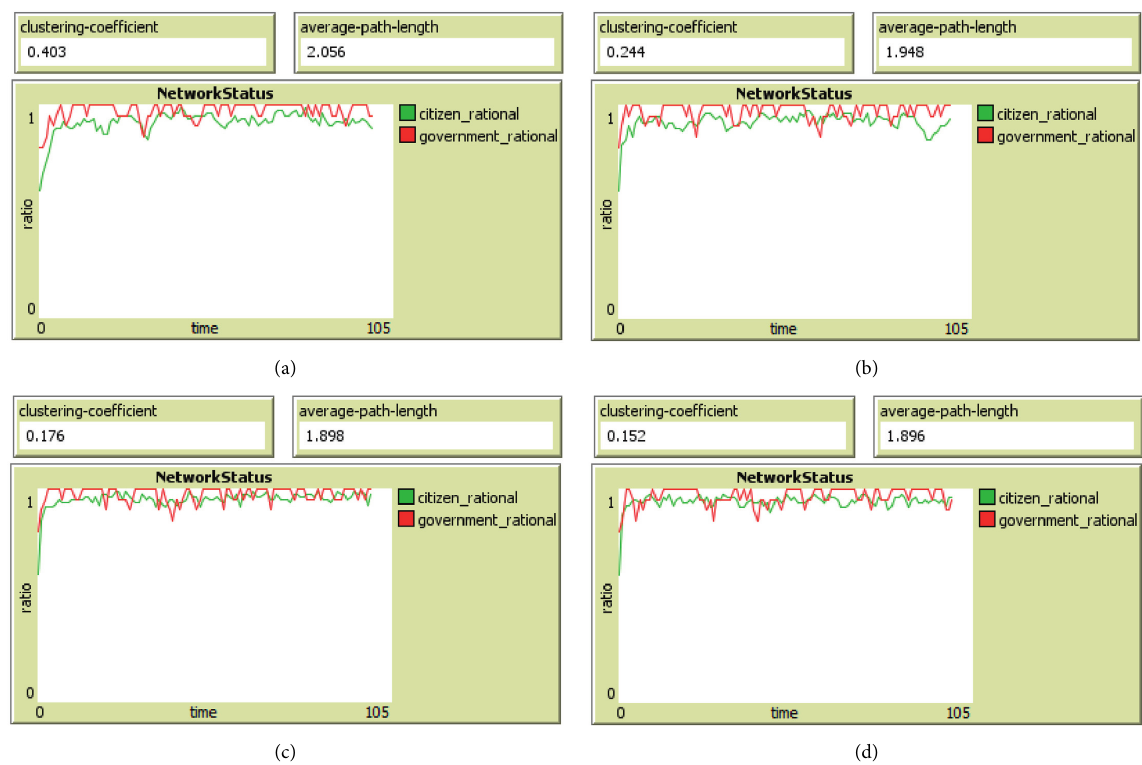
Figure 6: The evolutionary result when the reconnection probability p of the small-world network takes different values under scenario two (the initial state is located in region III and IV): (a) the evolutionary result when p � 0.2; (b) the evolutionary result when p � 0.4; (c) the evolutionary result when p � 0.6; (d) the evolutionary result when p � 0.8.